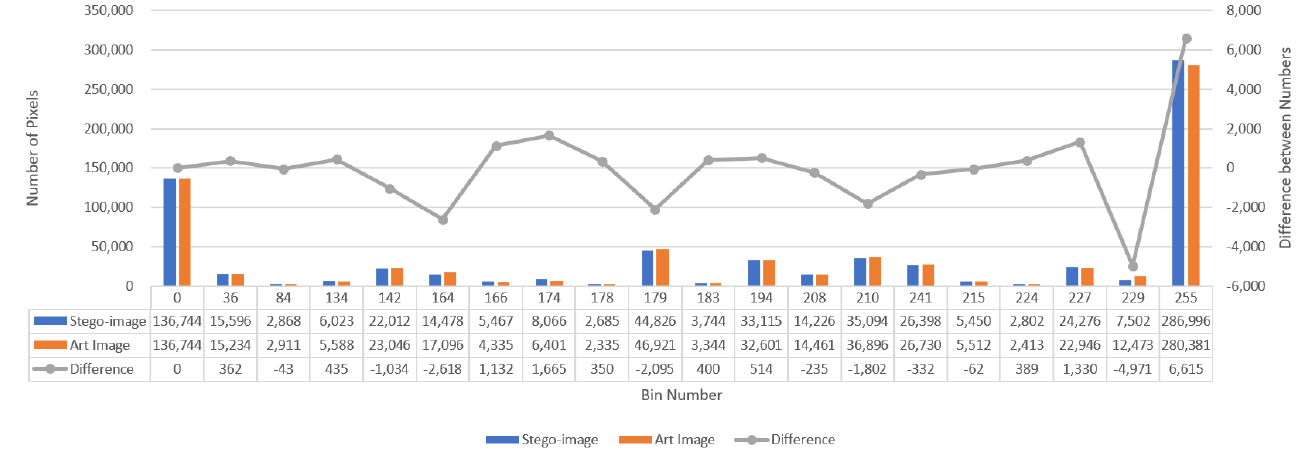
Figure 21. The histograms of the cover art image (shown as red-colored bars) and the corresponding stego-image (shown as blue bars) created from an image (the first image in Table 4), as well as their difference (shown as the gray line chart).